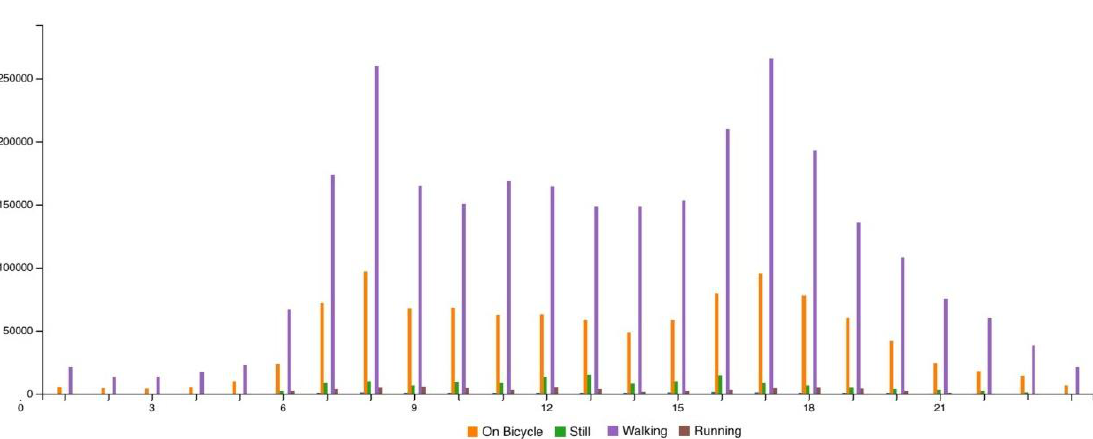
Figure 4. Distribution of minutes of all activities against time of day for all days.